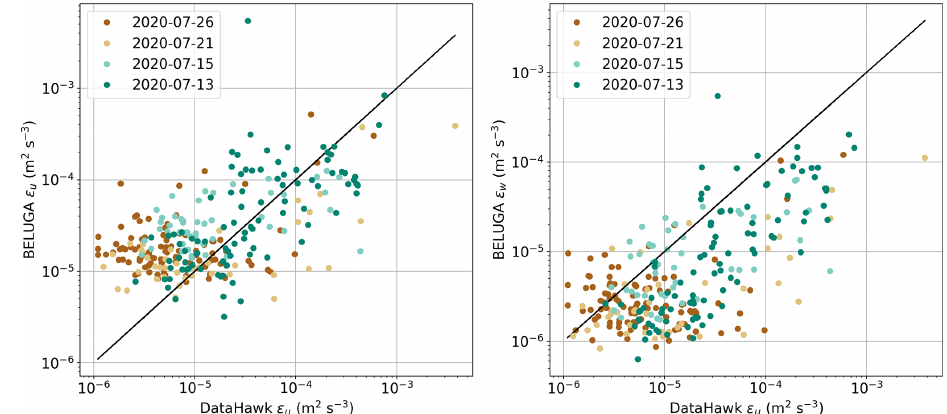
Figure 4. Comparison of dissipation rates ε for BELUGA and DH2 for all concurrent fight times. Each data point represents a 10m height interval with averaged ε for the daily data shown in Fig. 1. For BELUGA, dissipation rates are calculated for the horizontal wind component u and the vertical component w . The black line represents the 1 : 1 relation.